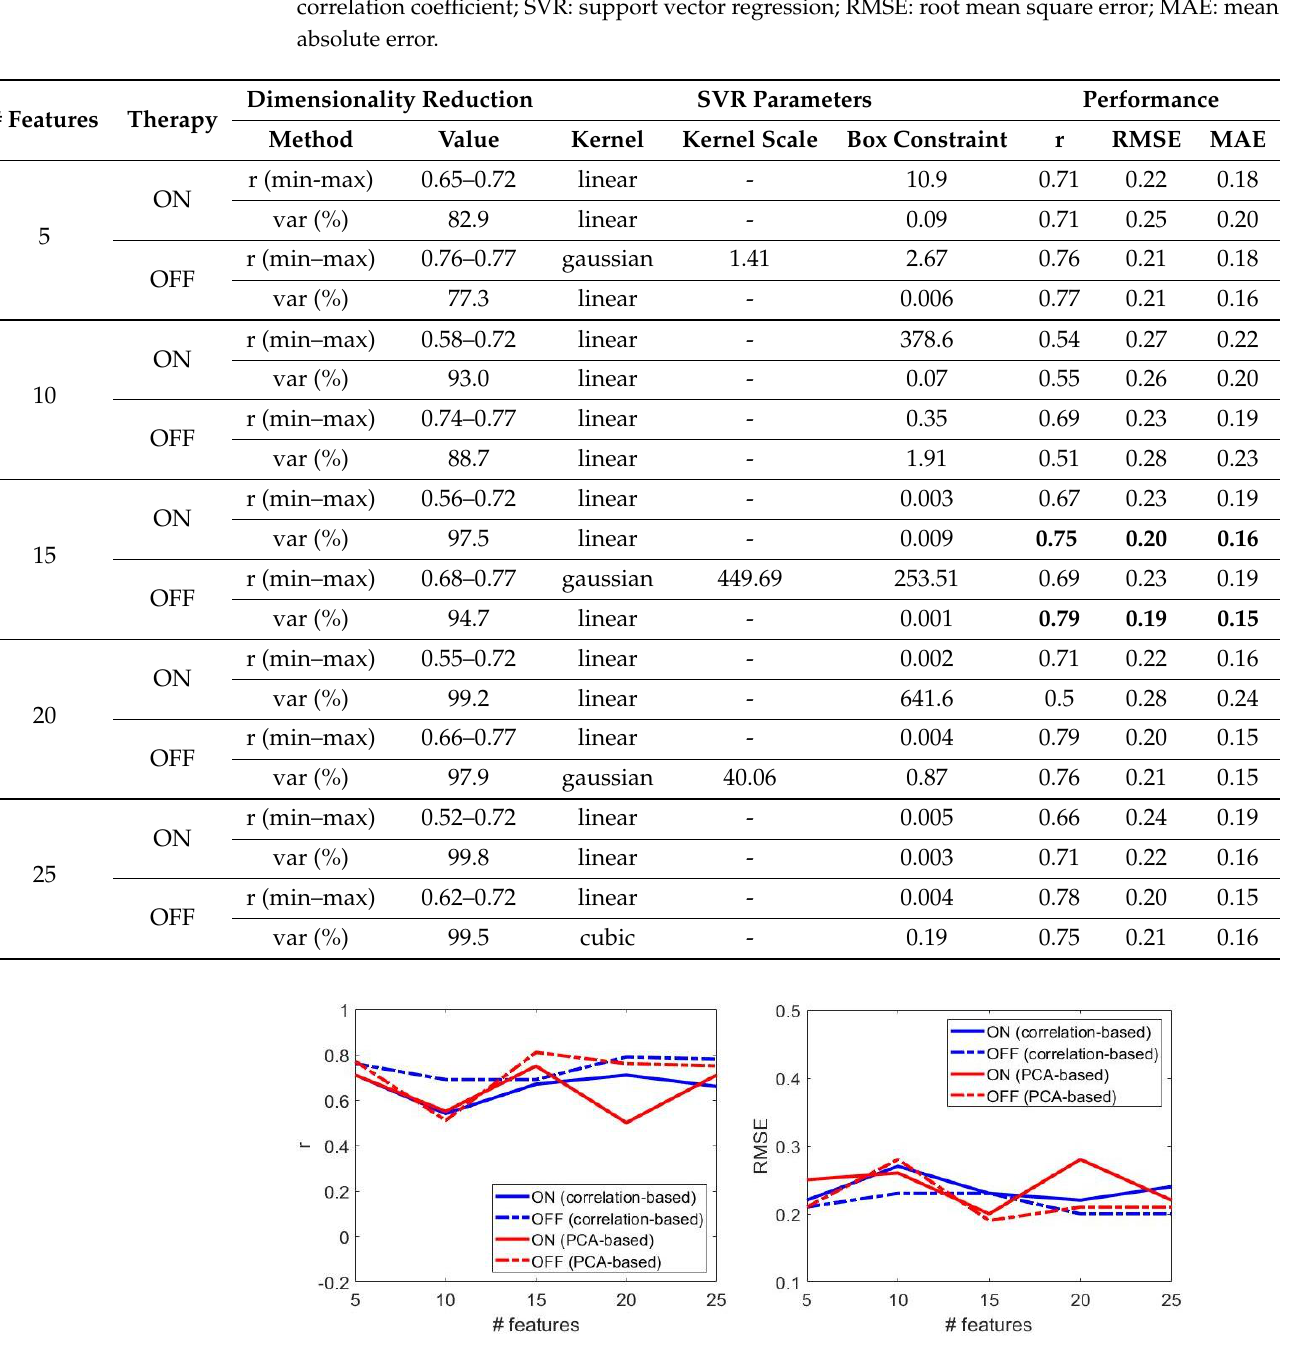
Figure 7. The effect of therapy on the regression model performances, in terms of correlation coefficient ( left ) and root mean square error ( right ). ON: under dopaminergic therapy; OFF: not under dopaminergic